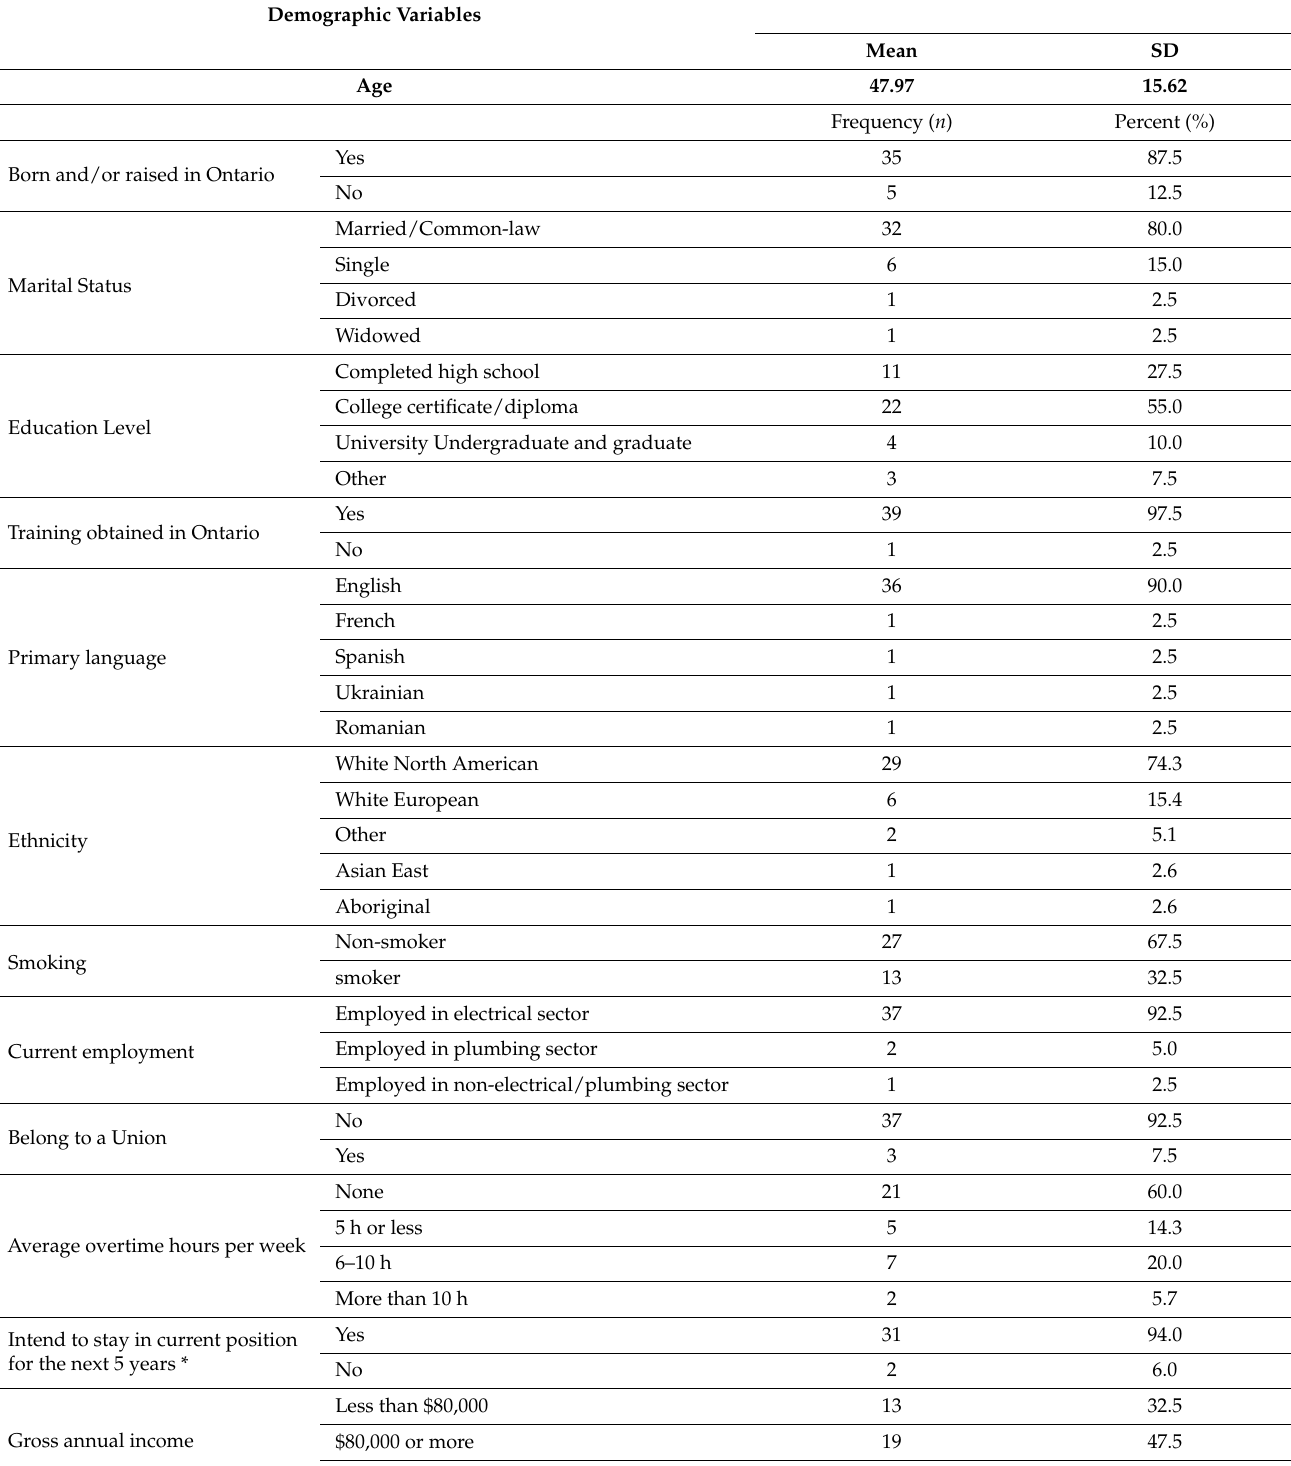
Table 1. Demographic characteristics of study participants ( n =